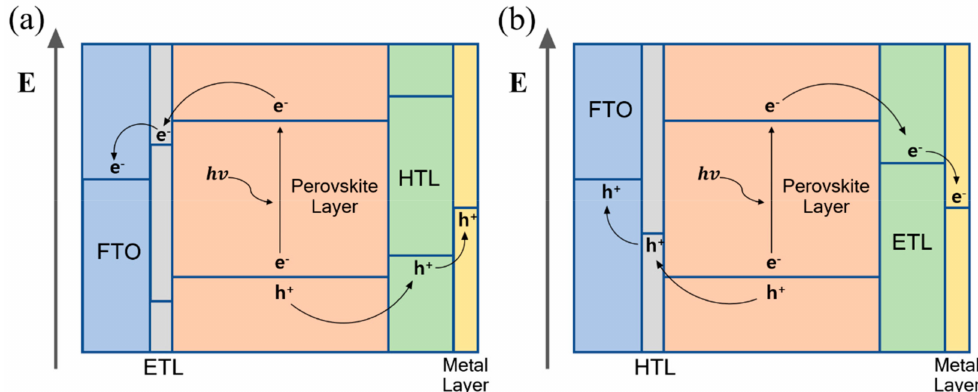
Figure 3. The operating mechanism of perovskite-based photoelectrochemical device ( a ) n–i–p configuration, ( b ) p–i–n